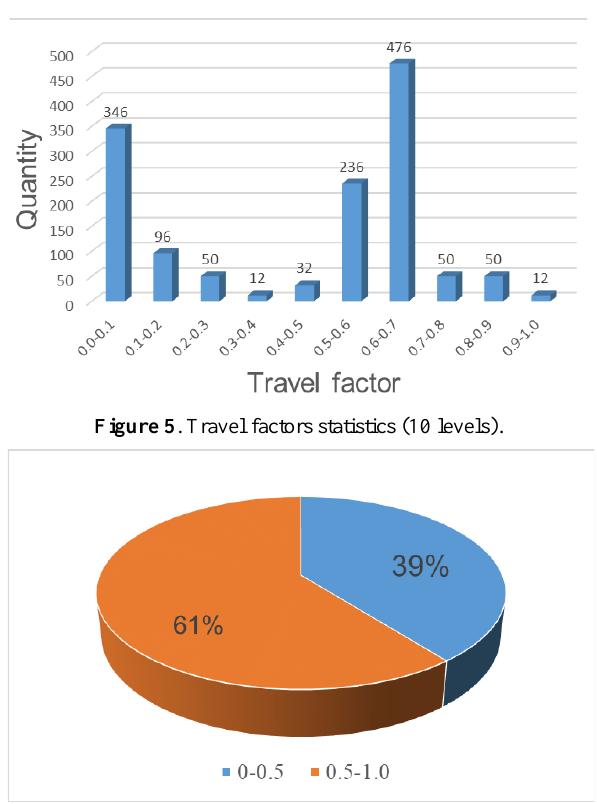
Figure 6 . Traffic conditions of residential points in Wenchuan County.